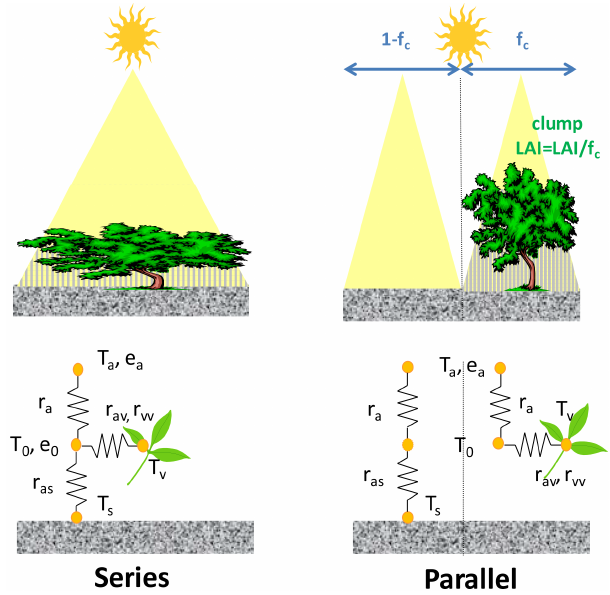
Figure 1. Schematic showing the series and parallel model ap-